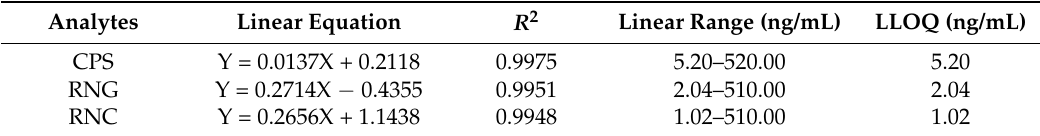
Table 2. The linear equation, correlation coefficients ( R 2 ), linear ranges, and lower limit of quantification (LLOQ) of CPS, RNG, and RNC in rat